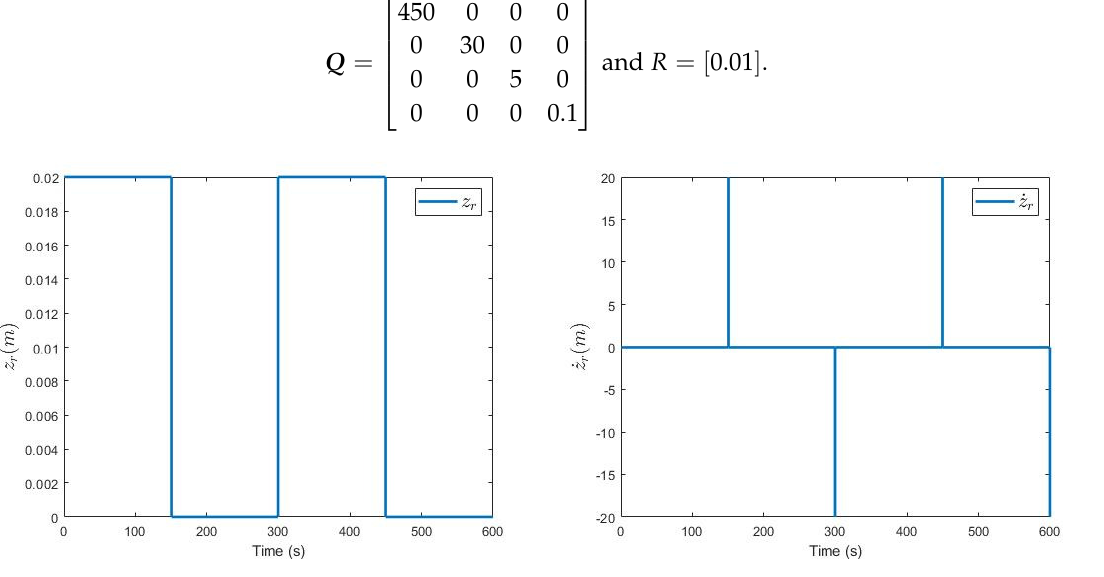
Figure 6. Scenario 1 road